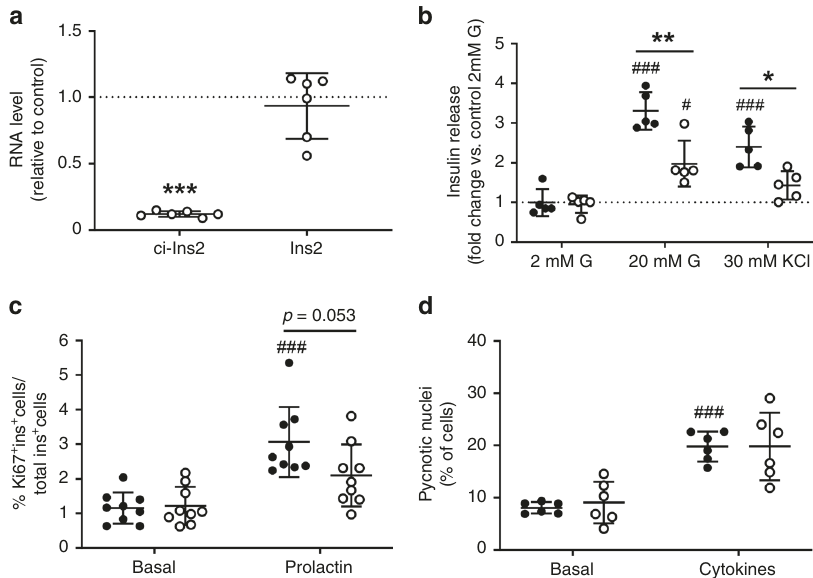
Fig. 4 ci-Ins2 is involved in rat β -cell secretory activity. a – d Dissociated rat islet cells were transfected with control (black circles) or ci-Ins2 (clear circles) gapmeRs. Experiments were performed 48 h after transfection. a ci-Ins2 and Ins2 normalized to Hprt1 , measured by qPCR, and expressed relative to control. n = 6 independent experiments. *** p < 0.0001 by two-tailed one-sample t -test. b Insulin secretion in response to 2 mM glucose (G), 20 mM G, or 30 mM KCl represented as the fold change vs. control basal (2 mM G) condition. n = 5 independent experiments. * p = 0.018 and ** p = 0.0007 as indicated, and # p = 0.016, ### p < 0.0001 (20 mM G) and ### p = 0.0004 (30 mM KCl) vs. 2 mM G control by one-way ANOVA and Tukey post hoc test. c Basal and 48 h prolactin-stimulated β -cell proliferation determined by Ki67 and insulin staining. n = 9 independent experiments. ### p = 0.00005 vs. basal control condition by one-way ANOVA and Tukey post hoc test. d Basal and 24 h cytokine-induced apoptosis determined by scoring pycnotic nuclei. n = 6 independent experiments. ### p = 0.0002 vs. basal control condition by one-way ANOVA and Games-Howell post hoc test. a – d Data and mean are represented ± s.d. Source data are provided as a Source Data fi le.